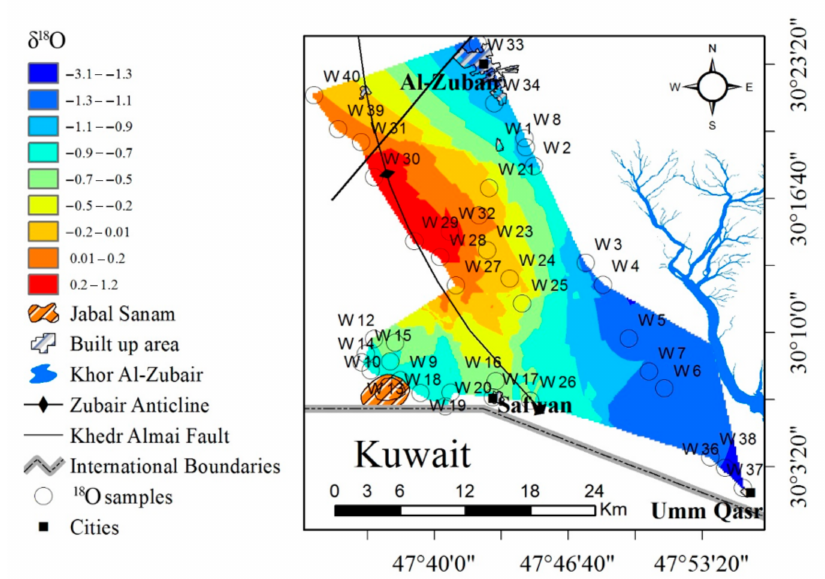
Figure 5. Distribution of δ 18 O for the groundwaters from the